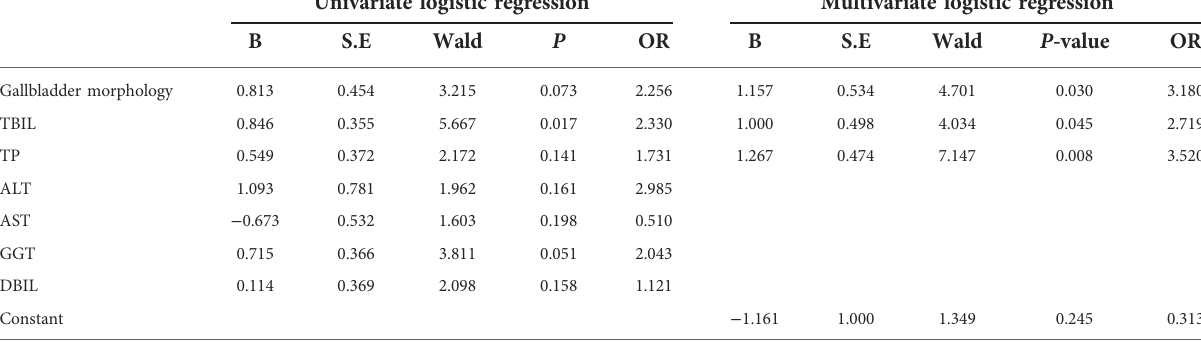
TABLE 2 Univariate and multivariate logistic regression analyses in the training cohort. Univariate logistic regression Multivariate logistic